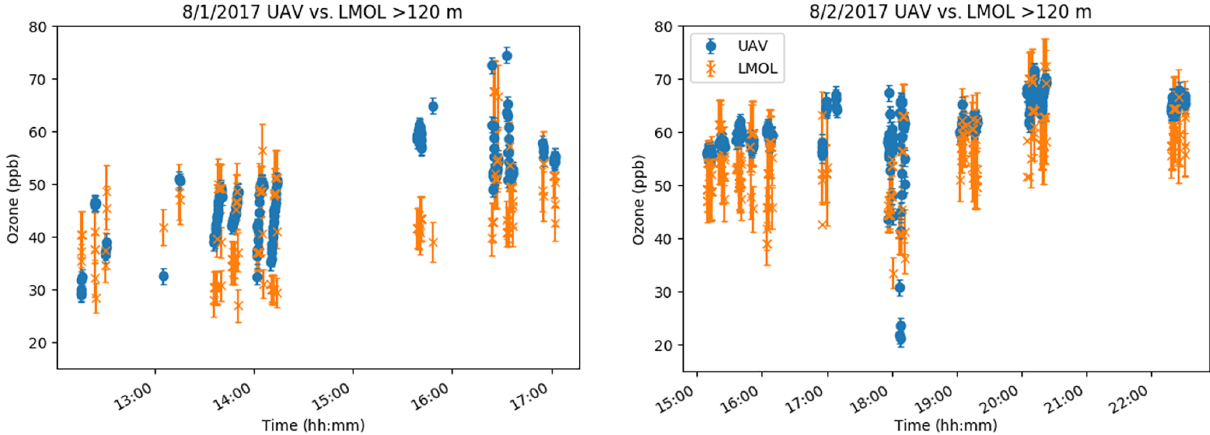
Figure 5. Time series for 1–2 August 2017 of UAV measurements above 120m and the corresponding LMOL data.